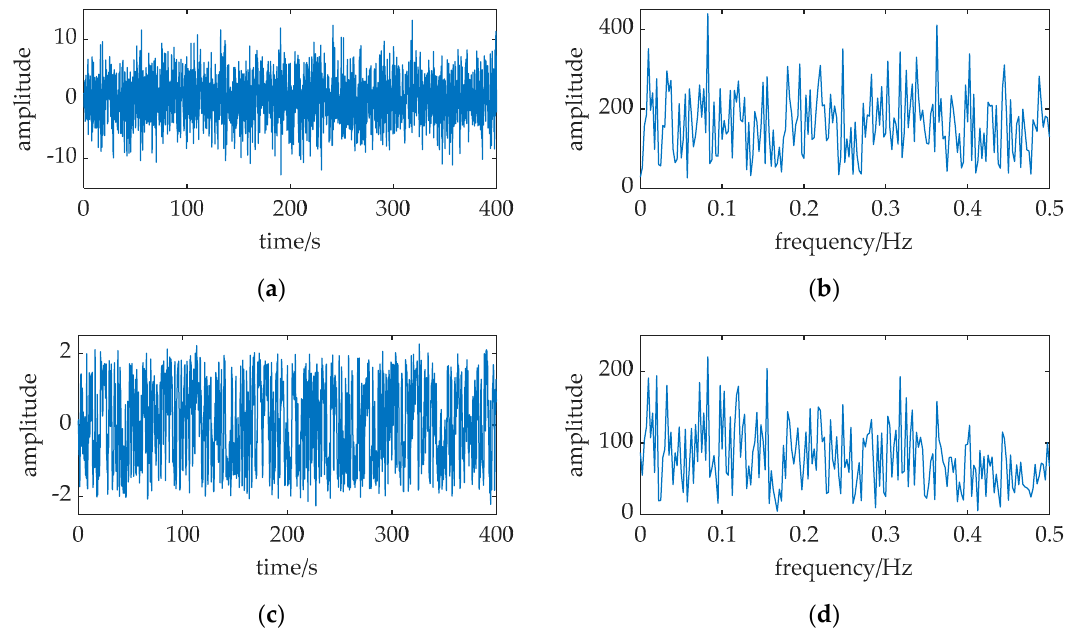
Figure 6. The SR of signal with large noise. The relative parameters: A = 0.5, f = 0.01, a = 1, b = 1, D = 7.75, f s = 5. (a),(b) are the waveform and frequency spectrum of the input; (c),(d) are waveform and frequency spectrum of the SR output.